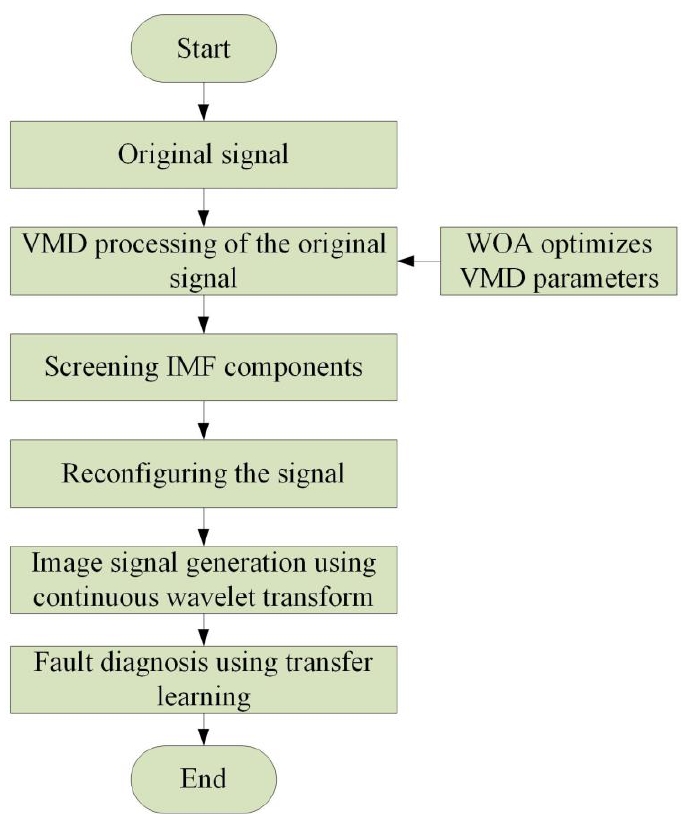
Figure 1. The role of WOA-VMD in fault diagnosis.